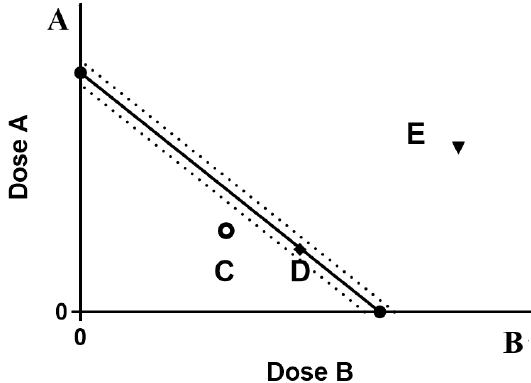
Figure 7. Isoradiation analysis of drugs A and B.